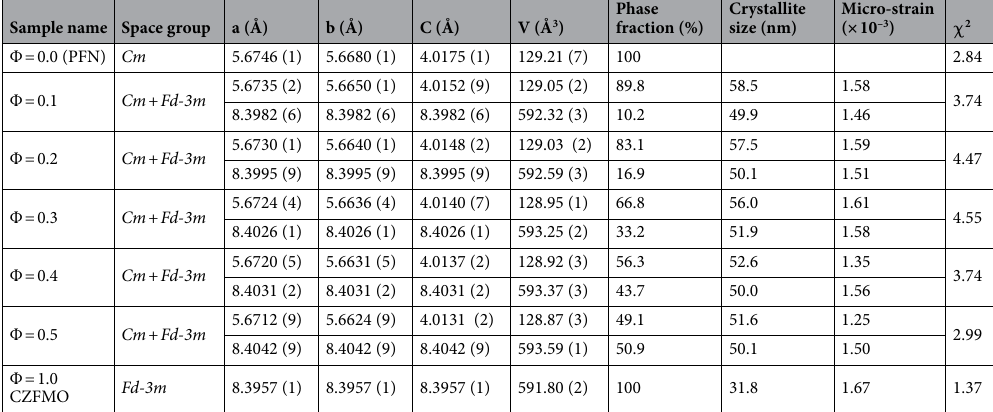
Table 1. Crystal structure parameters (obtained from Rietveld refinement analysis) and the micro-strain and average crystallite size of PFN and CZFMO phase (obtained from W–H plot) of (1 − Φ) PFN-Φ CZFMO (Φ = 0.0, 0.05, 0.1, 0.2, 0.3, 0.4, 0.5, 1.0)